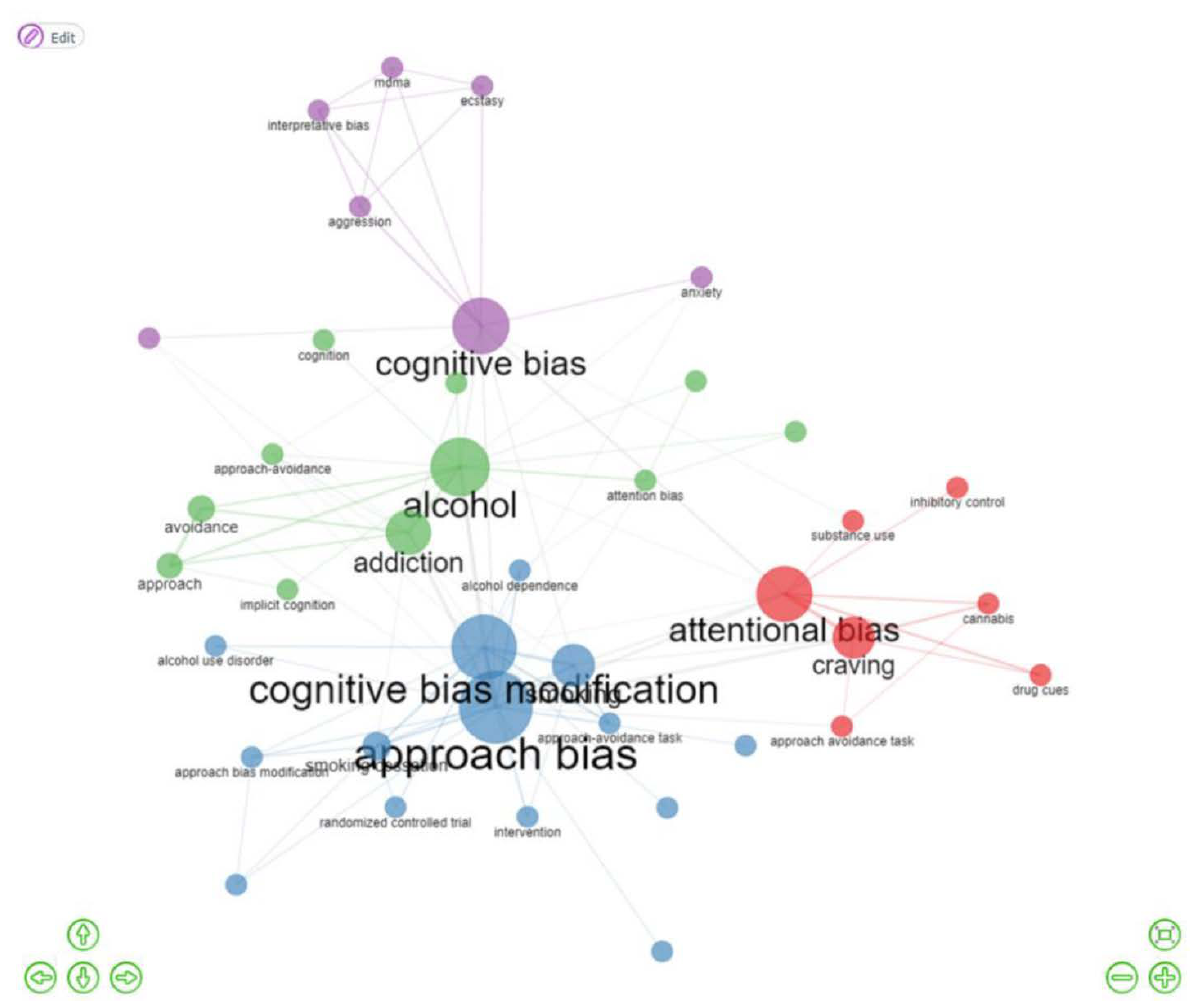
Figure 6. An overview of the co-occurrence of authors’ keywords.